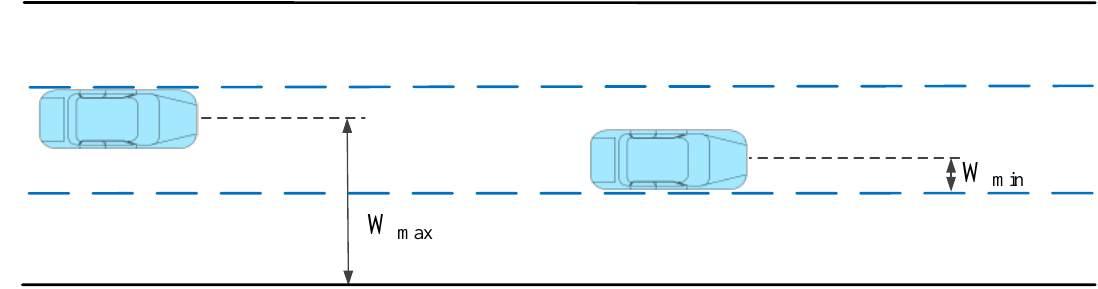
Figure 3. Determination of the lateral distance range.